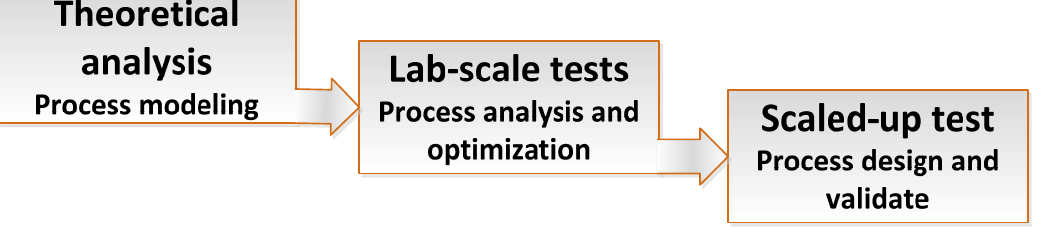
Figure 1. Process development methodology.